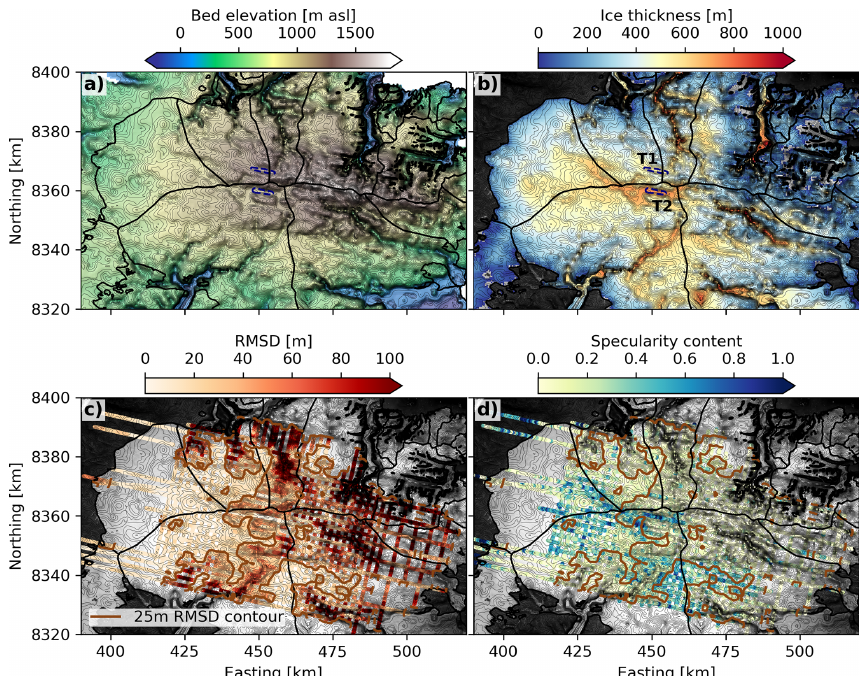
Figure 3. Subglacial bedrock morphology beneath DIC. (a) Updated bedrock DEM from this study with 25m contour lines. Thick black lines mark the boundaries of the glacier catchment areas. (b) Ice thickness derived via a subtraction of the bedrock DEM from the ArcticDEM ice surface elevation (Porter et al., 2018). The location of the previously inferred subglacial lakes in bedrock troughs T1 and T2 (Rutishauser et al., 2018) is marked with blue dashed lines. Background is a Landsat image overlain with the bedrock elevation contours (25m interval). (c) Basal roughness along profile lines expressed as the RMSD. The brown contour marks a RMSD of 25m (chosen based on visual correlation with specularity anomalies). (d) Specularity content along the profile lines, overlain with the 25m RMSD contour line